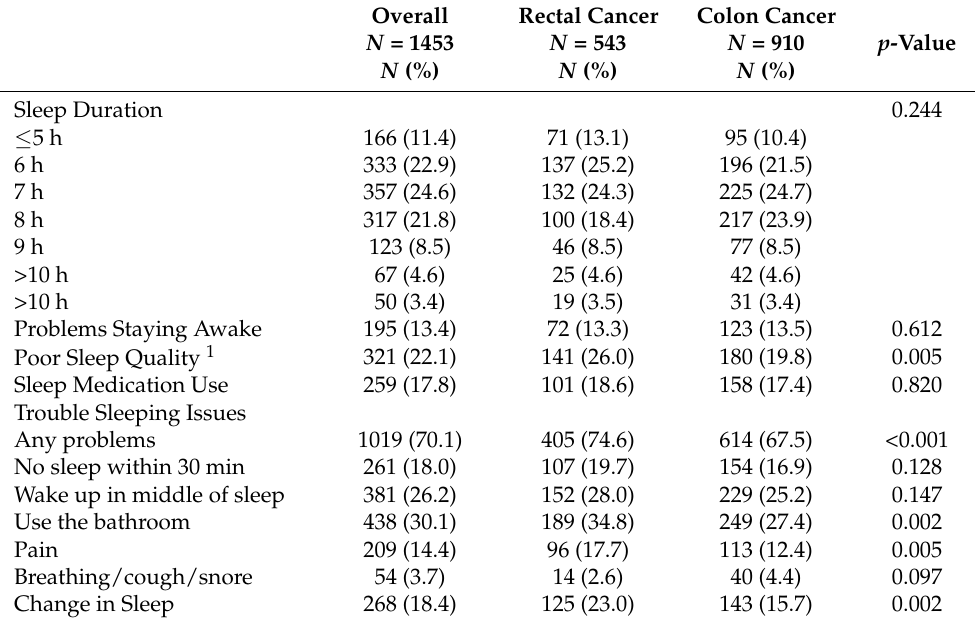
Table 2. Differences in sleep quality by CRC site (N =